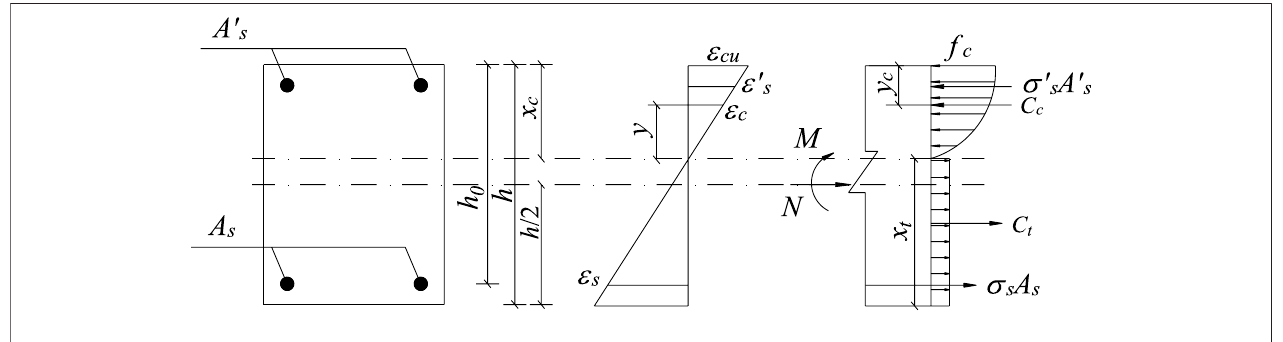
FIGURE 4 | Stress and strain